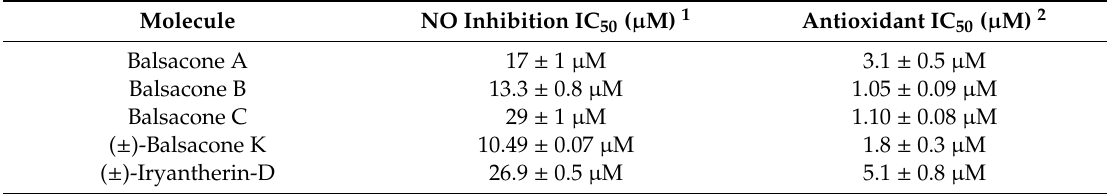
Table 2. Summary of anti-inflammatory and antioxidant activities of